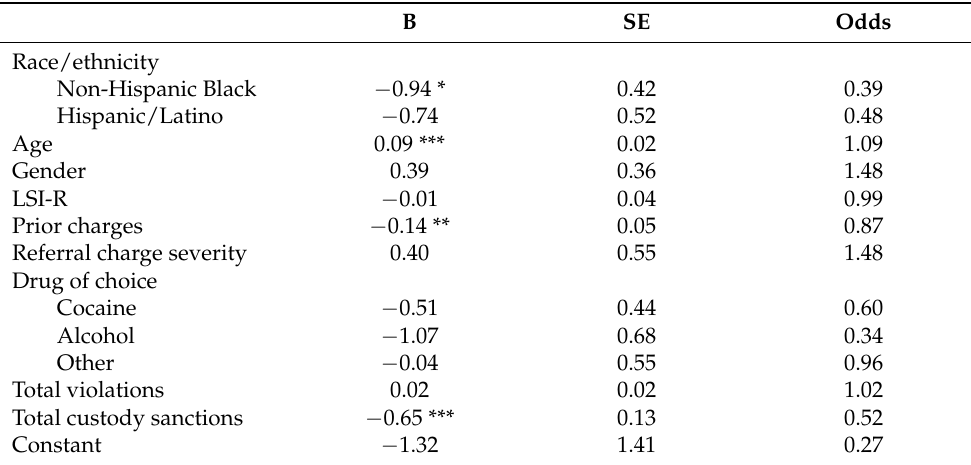
Table 5. Logistic Regression Results for Likelihood of Graduation ( N =